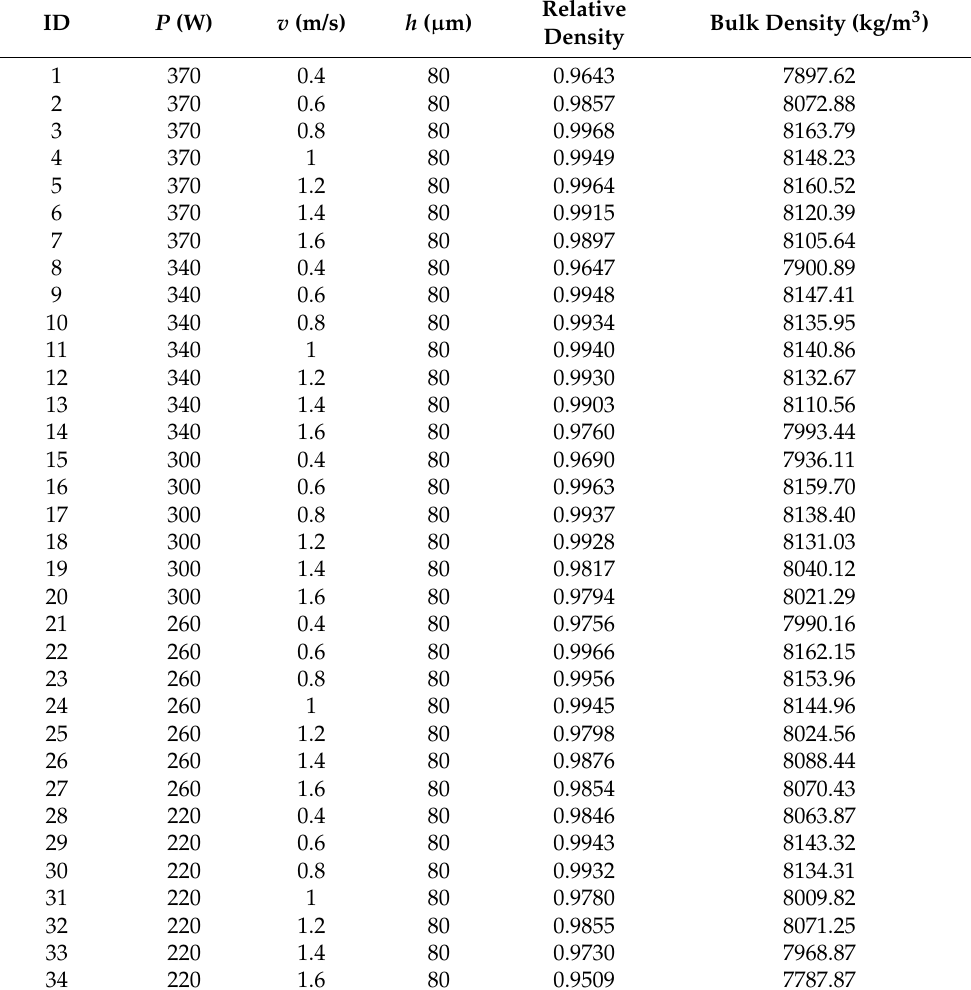
Table A2. Manufacturing parameters and experimental data adapted from [16]. Complement- ing relevant information and assumptions are the following; material: In718, theoretical density